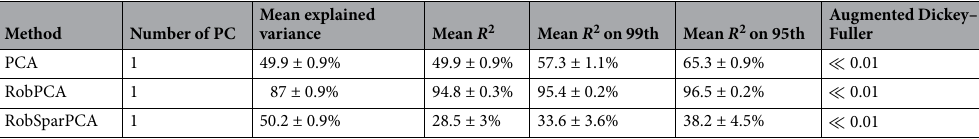
Table 2. Results from Robust PCA. Mean is evaluated over years. Mean Explained Variance is evaluated from 2 the eigenvalues of PCA, R is reported for the full dataset and for the 99th and 95th percentiles. In analogy 2 with the classical R , we compute the RSS term as the squared residuals given after the reconstruction step using only the retained principal components and the TSS term as the total variance contained in the original variables. Augmented Dickey–Fuller test for stationarity of the ESR index as well.